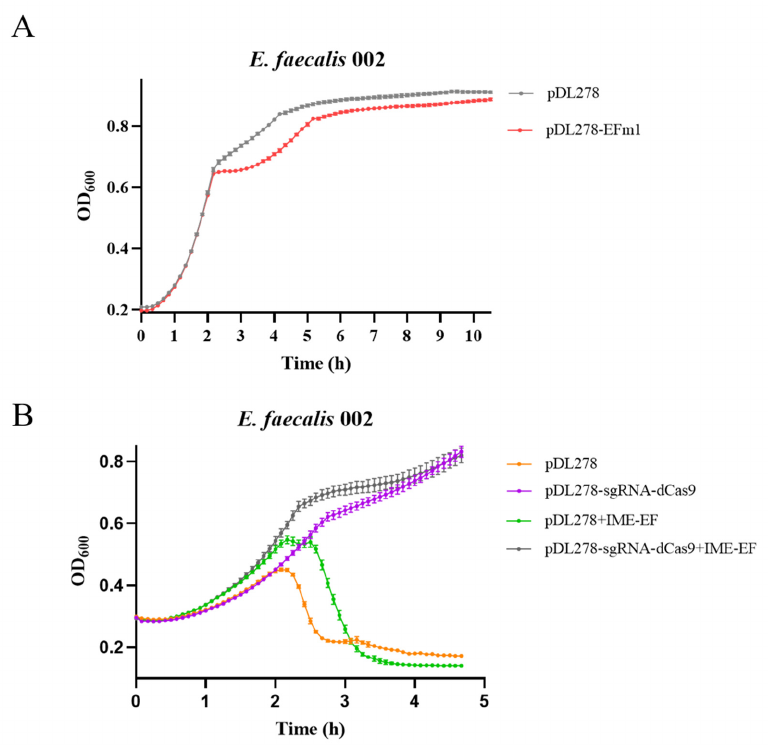
Figure 9. Expression and CRISPRi of EFm1 in 002. ( A ) Growth dynamics of 002 with the plasmid pDL278 or pDL278- efm1 ; the mean ± s.e.m is shown; ( B ) Growth dynamics of 002 with the plasmid pDL278 or pDL278-dCas9-sgRNA followed by infection without or with the phage IME-EF1 (MOI = 0.1); the mean ± s.e.m is shown.